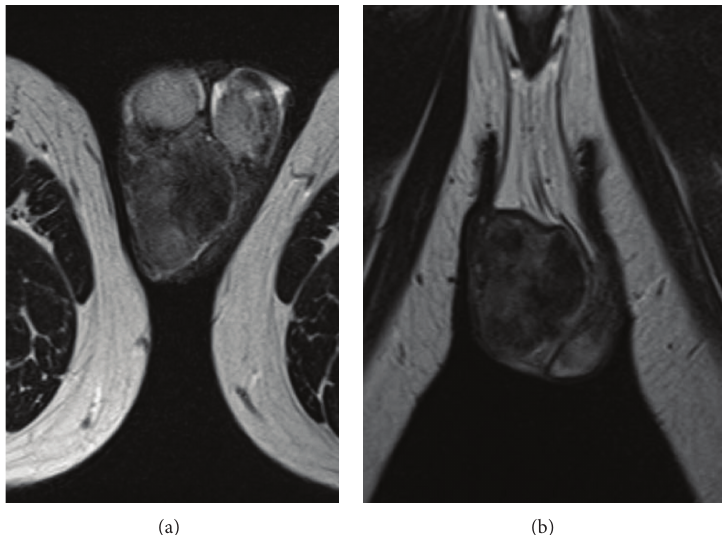
Figure 1: MRI T2 transverse (a) and coronal (b) images show a mass in the right paratesticular region.